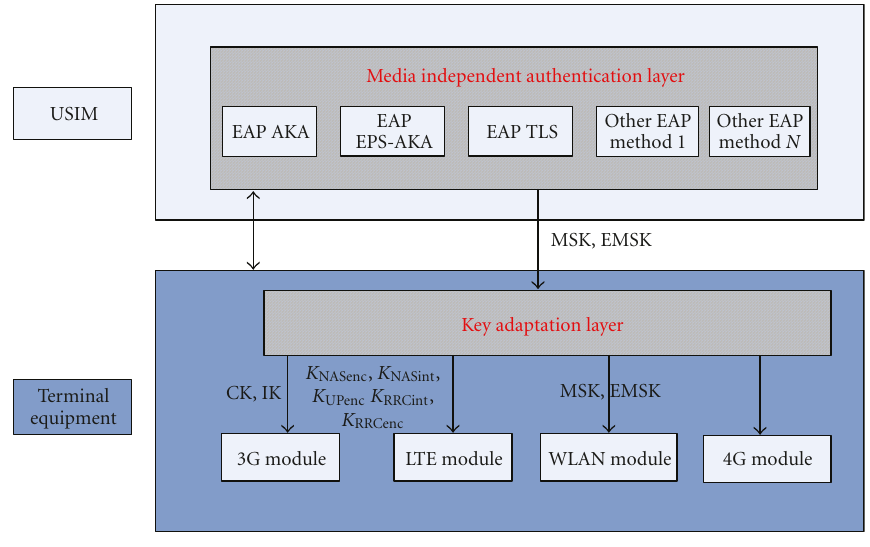
Figure 8: Uniform Access Authentication Framework on